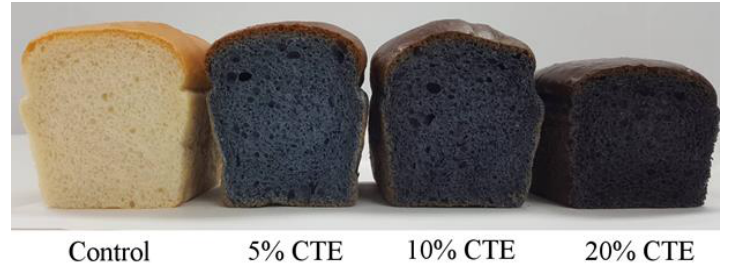
Figure 4. The cross section of bread made from wheat flour and CTE.